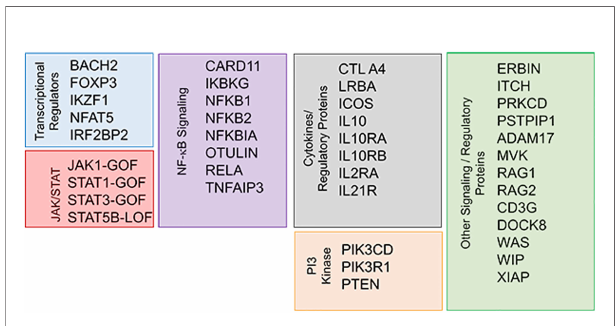
FIGURE 2 | Genetic defects associated with primary immune dysregulation disorder (PIRD) (46, 47). Reproduced with permission